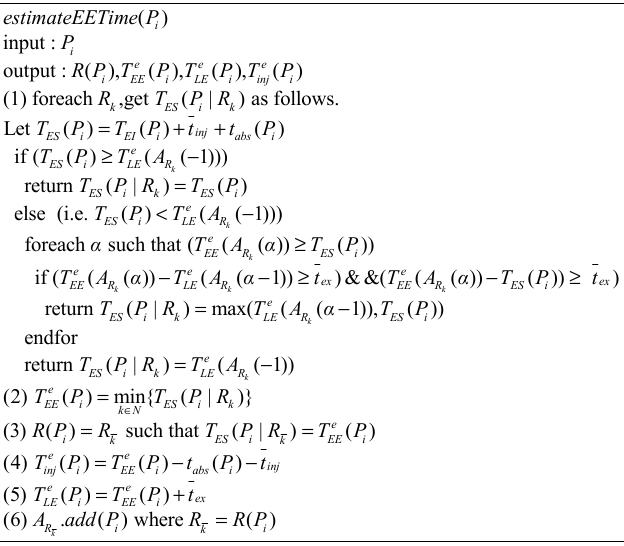
Figure 5. Bed allocation algorithm.